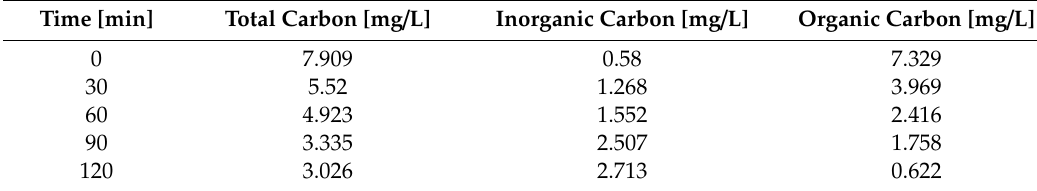
Table 6. Carbon content before and after adsorption of liquid phase.